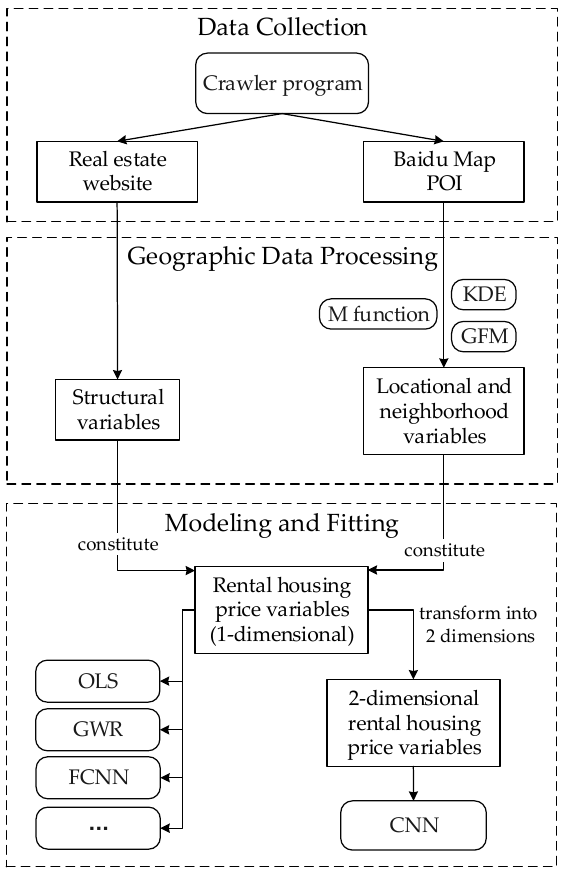
Figure 1. The overall research flowchart of this paper.